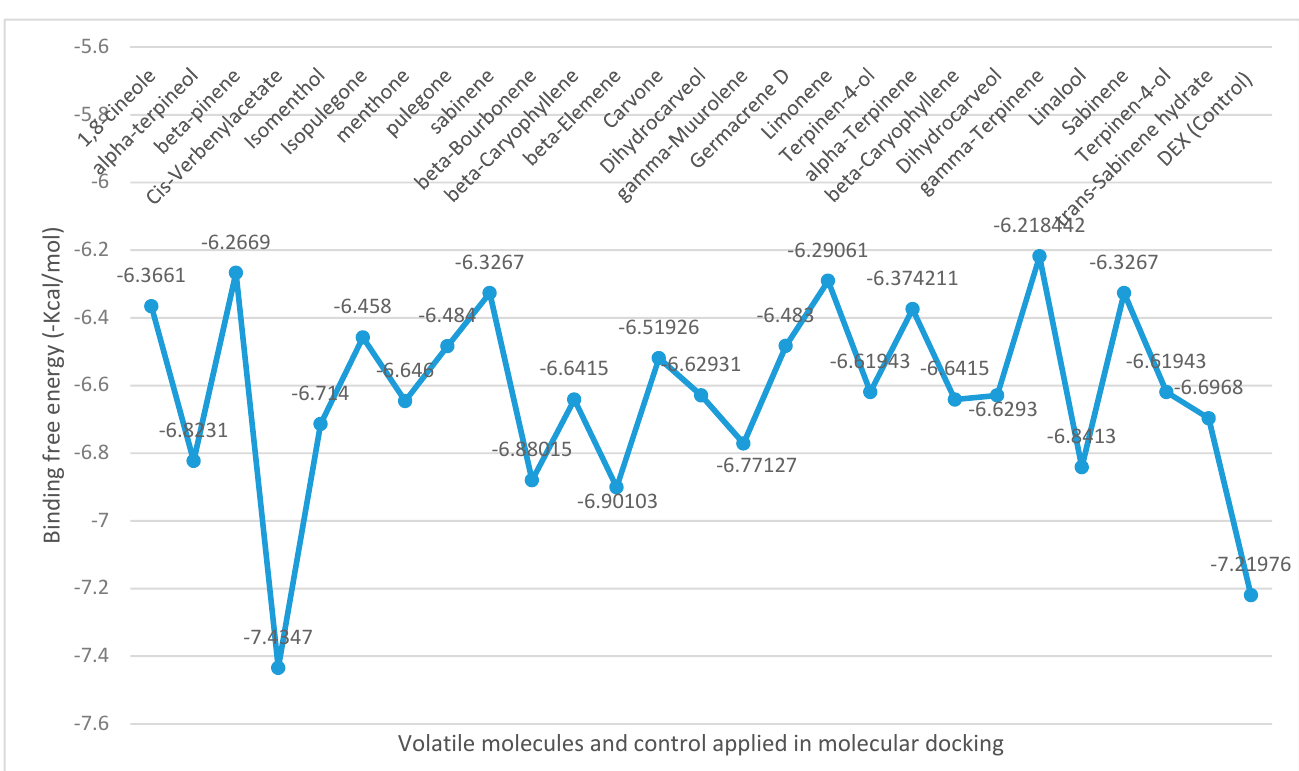
Figure 2. Binding free energy values calculated through the molecular docking of the major volatiles identified in lamiaceous plants and NO receptor.